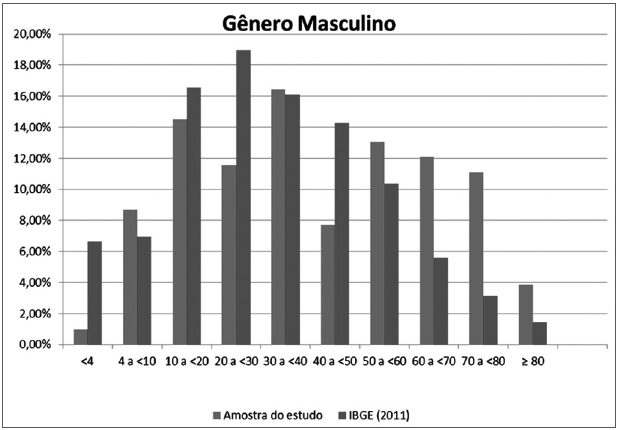
Figura 1. Comparativo da distribuição da amostra do sexo masculino, por faixa etária, com os dados populacionais (IBGE, 2011).